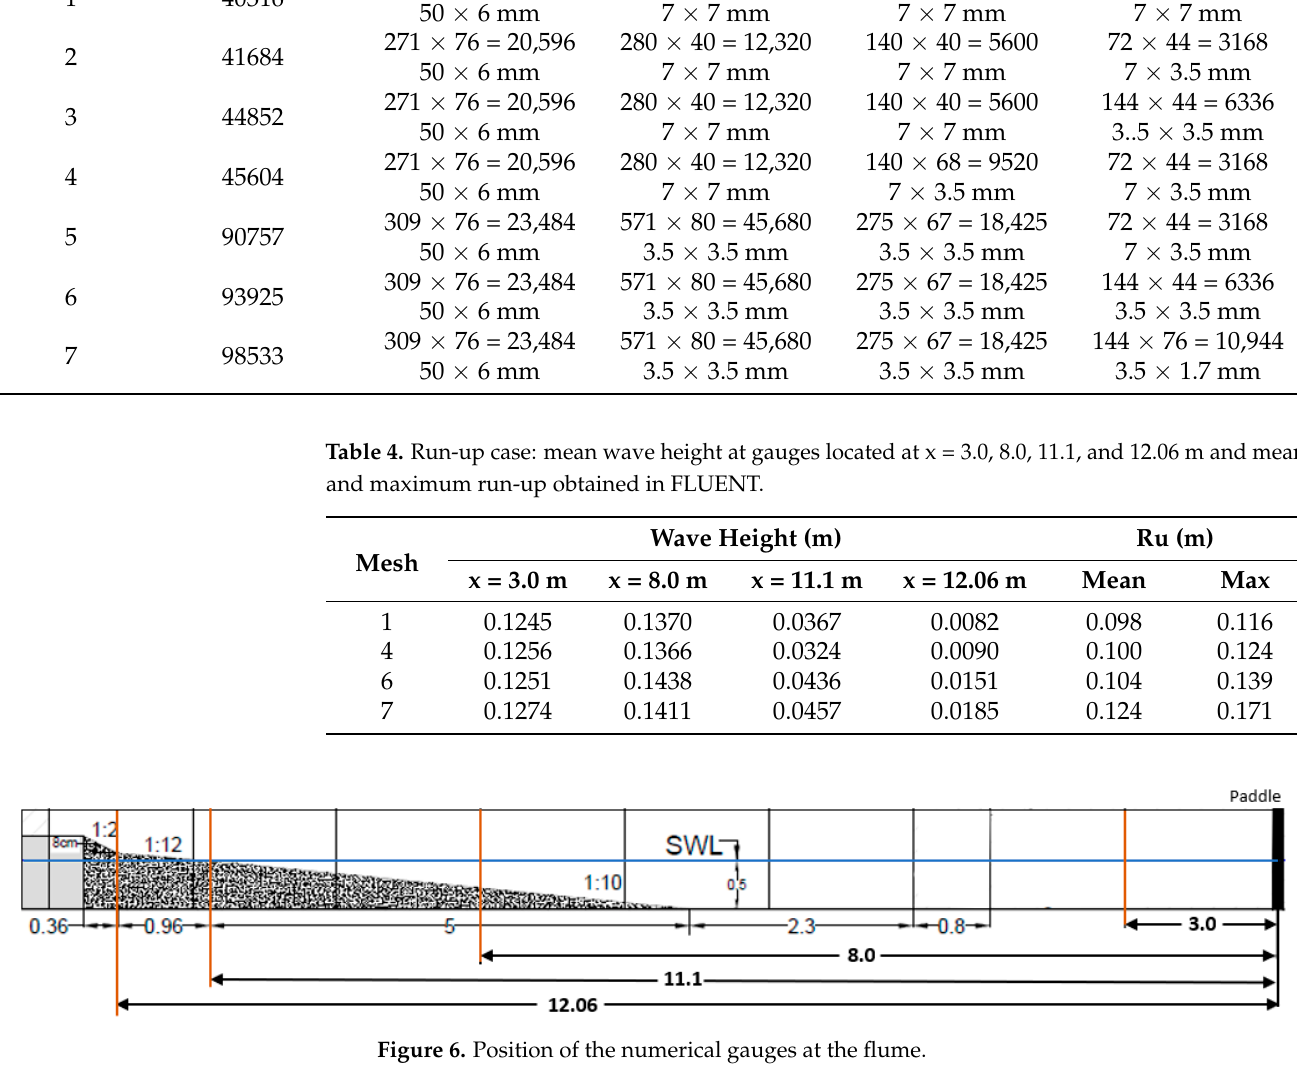
Table 3. Mesh characteristics zone by zone with total number of control volumes and number of control volumes in x and y discretisation used in FLUENT.